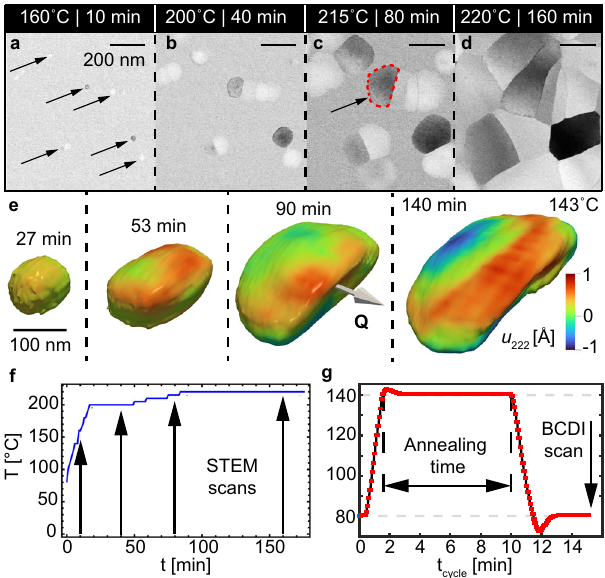
Fig. 1 In situ scanning transmission electron microscopy (STEM) and BCDI of single IZrO grain growth. a – d STEM bright- fi eld micrographs capturing the IZrO fi lm crystallization process while heating in the microscope. Arrows in a indicate a selection of initial crystallites, while the grain highlighted by the red dashed contour in c exhibits a similar morphology to that analyzed by BCDI (see the full movie of the crystallization sequence in Supplementary Movie 1). e Three-dimensional BCDI reconstruction of a single-grain growth during annealing of IZrO fi lm. Color encodes displacement fi eld u 222 ( r ). The direction of scattering vector Q is shown by the white arrow in the third panel. Temperature pro fi les of the STEM measurement ( f ) and typical annealing cycle for the BCDI experiment ( g